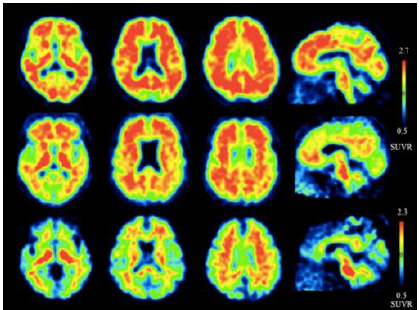
Figure 5. Representative axial and sagittal (18F)flutemetamol images of AD (upper row), mild cognitive impairment (middle row), and healthy controls (lower row) for the detection of Aβ [57]. Extensive uptake of flutemetamol can be observed in the cortical regions of AD and mild cognitive impairment patients. Images are reprinted with permission of the publisher [57].